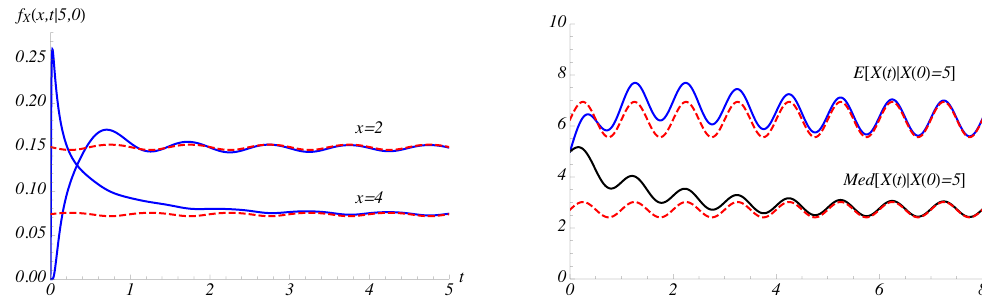
Figure 2. For the same choices as Figure 1, with x 0 = 5 and σ 2 = 2, on the left the transition densities are plotted for x = 2 and x = 4, whereas, on the right, the conditional mean and median (solid blue curves) are shown. The dashed curves indicate the corresponding asymptotic